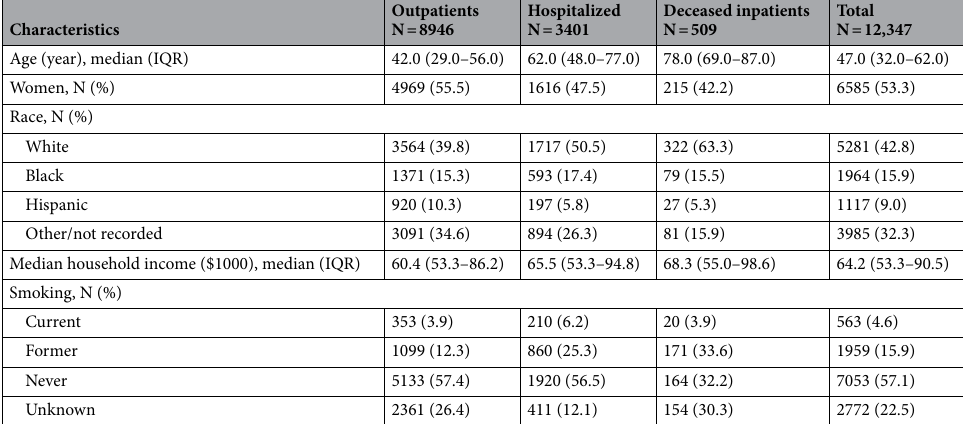
Table 1. Characteristics of N = 12,347 patients with COVID-19 from the Mass General Brigham electronic health records. IQR interquartile